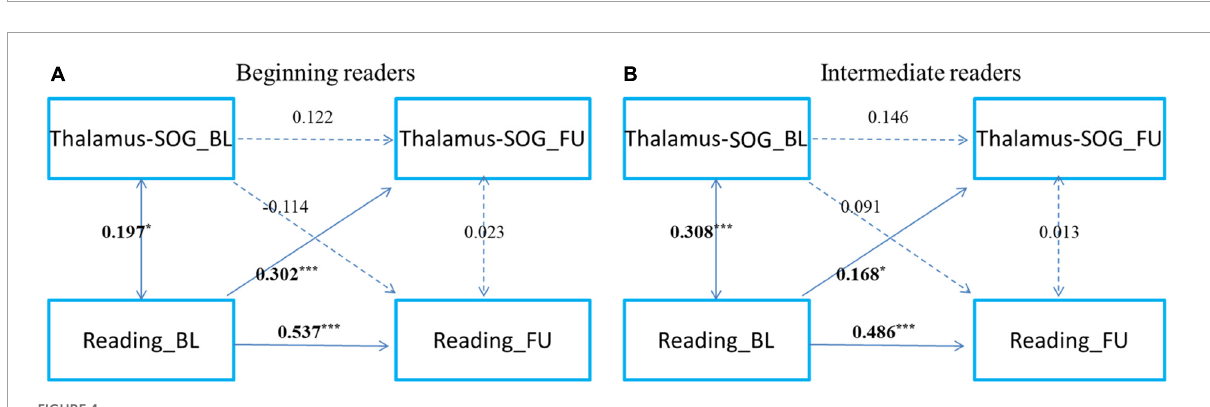
FIGURE4 The cross-time predictions between right thalamus and right superior occipital gyrus functional connectivity and reading development in school-age children The cross-lagged panel models in (A) beginning readers (grade 3 and below), and (B) intermediate readers (grade 4 and above). Standardized estimates are presented. SOG, superior occipital gyrus. Age, sex, handedness, site, household income, parental education, and head motion were used as covariates of no interest. * p < 0.05, ** p < 0.01, *** p <